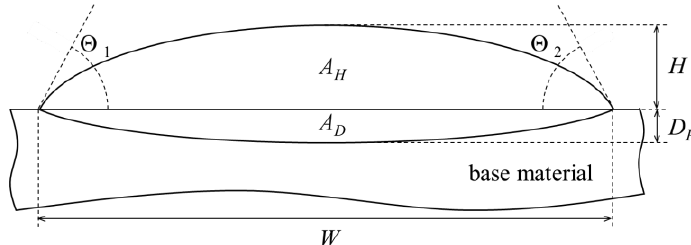
Figure 7. Geometric quantities for characterization of the weld seam.